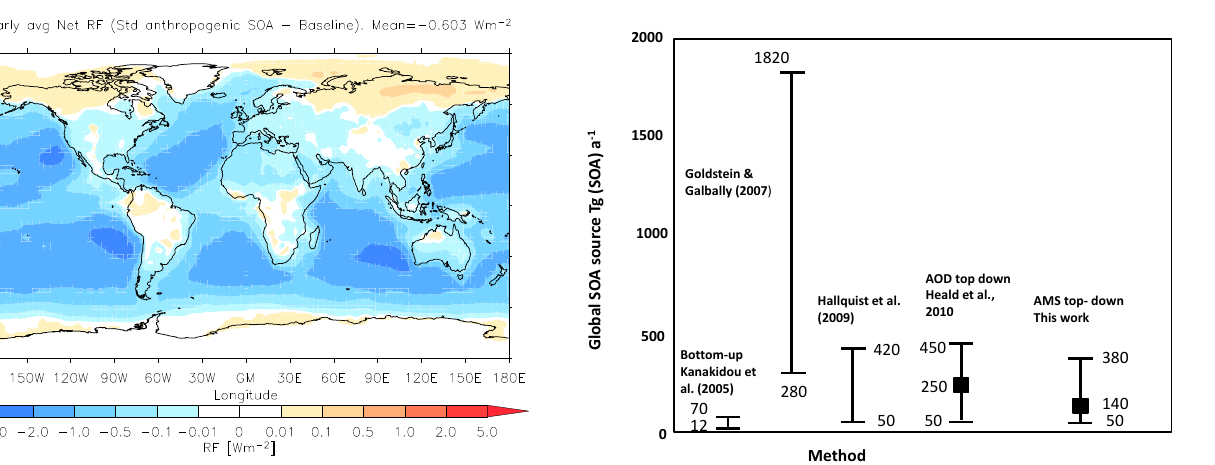
Fig. 13. Comparison of the global budget of SOA calculated here with previous work (we convert the OA source from Heald et al. (2010) into an SOA source assuming a 2:1 OA:OC conversion and the POA emissions used in this